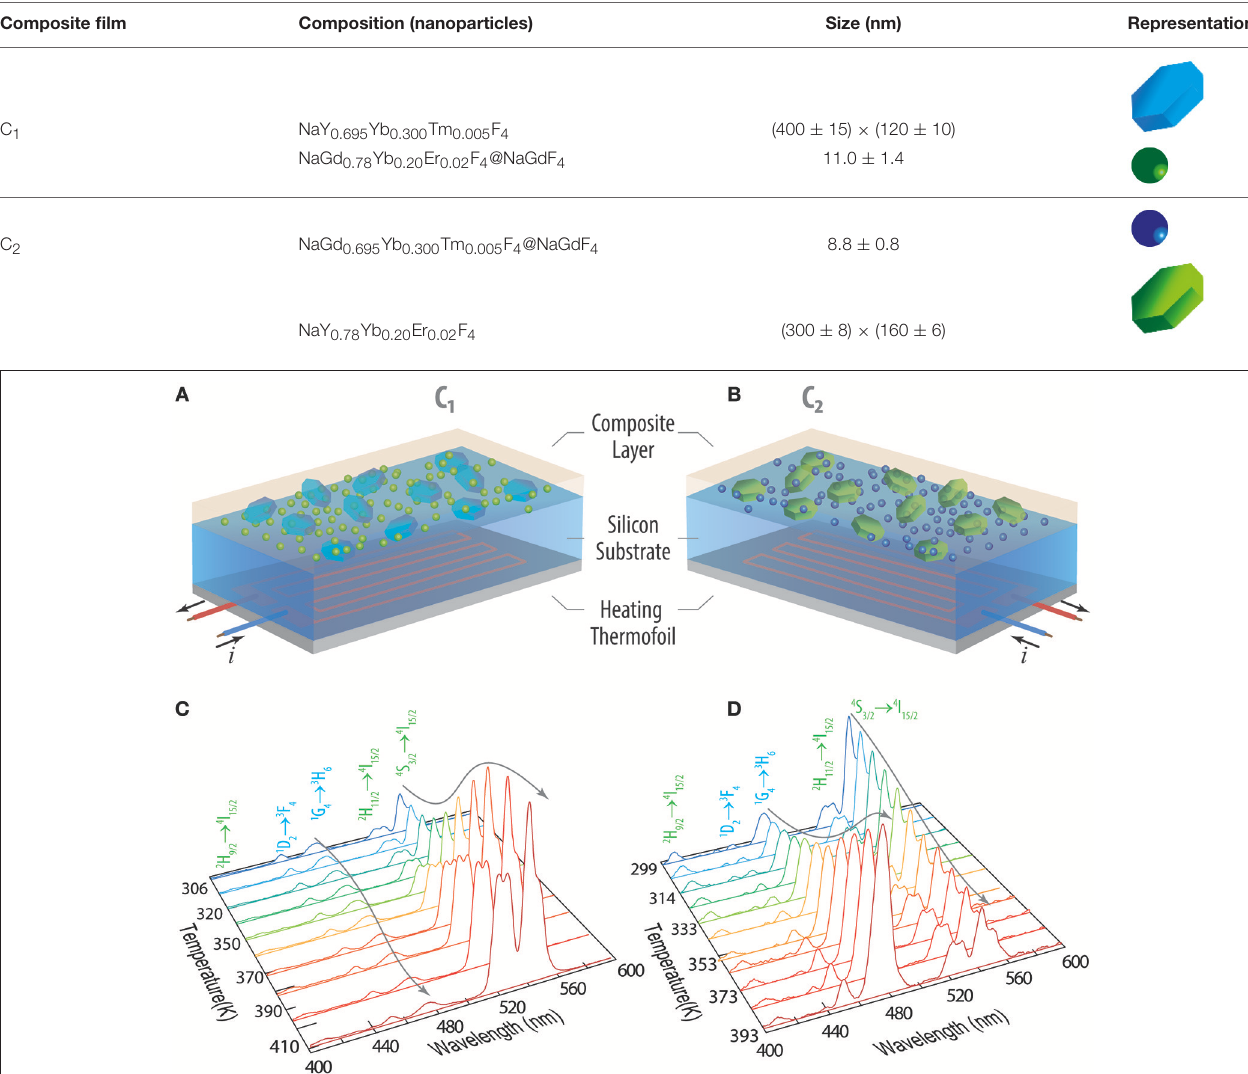
TABLE 1 | Nomenclature, nominal composition, and particle size ± std (determined using the TEM/SEM images) of the UCNPs embedded in the fabricated composite films.